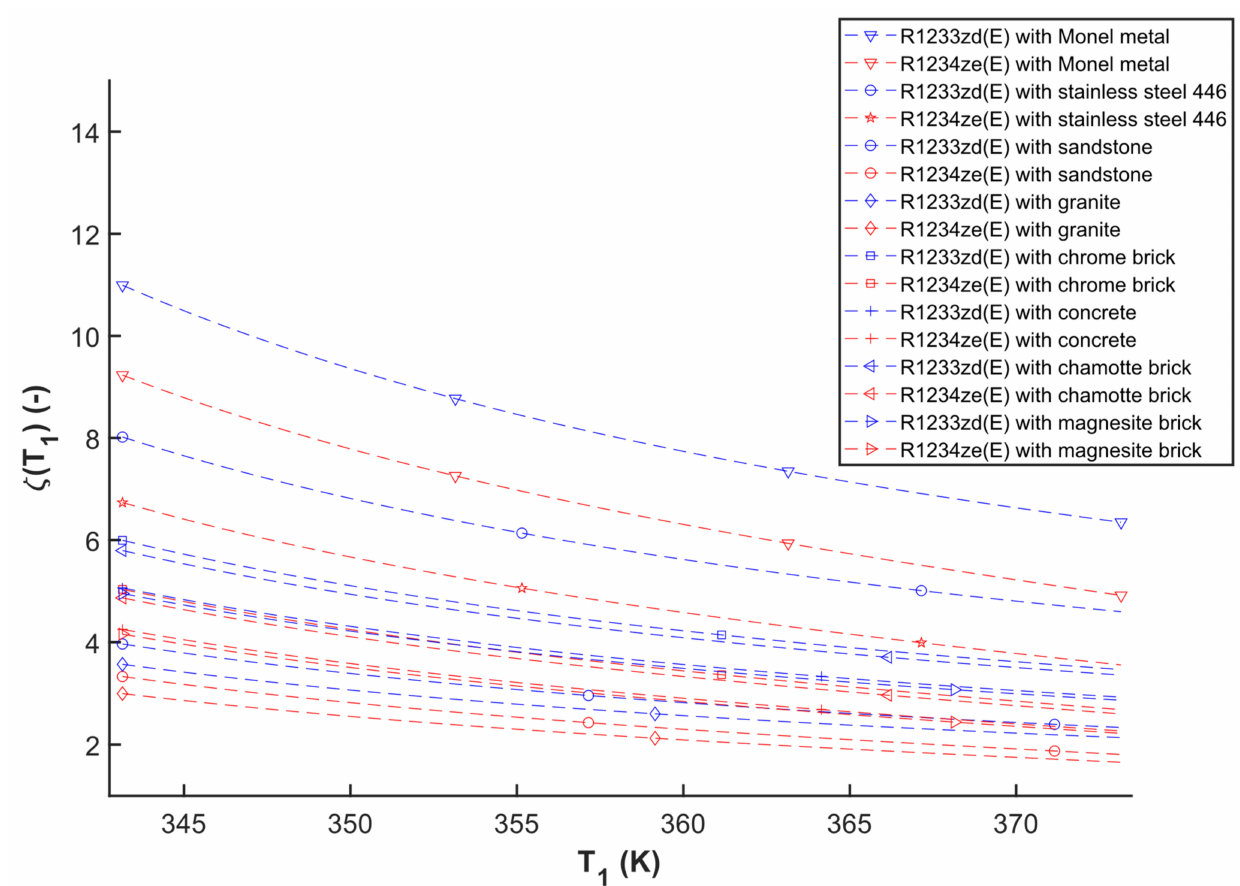
Figure 7. A ζ (T 1 )—T 1 diagram of different working fluids and TES materials simulated with the ∆ T 1 = 1